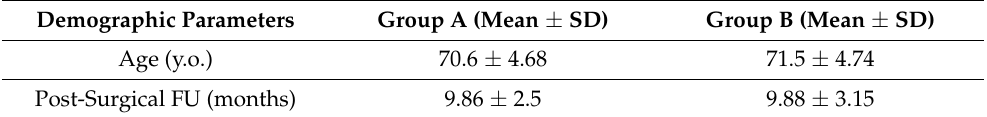
Table 1. Demographic parameters of study population.